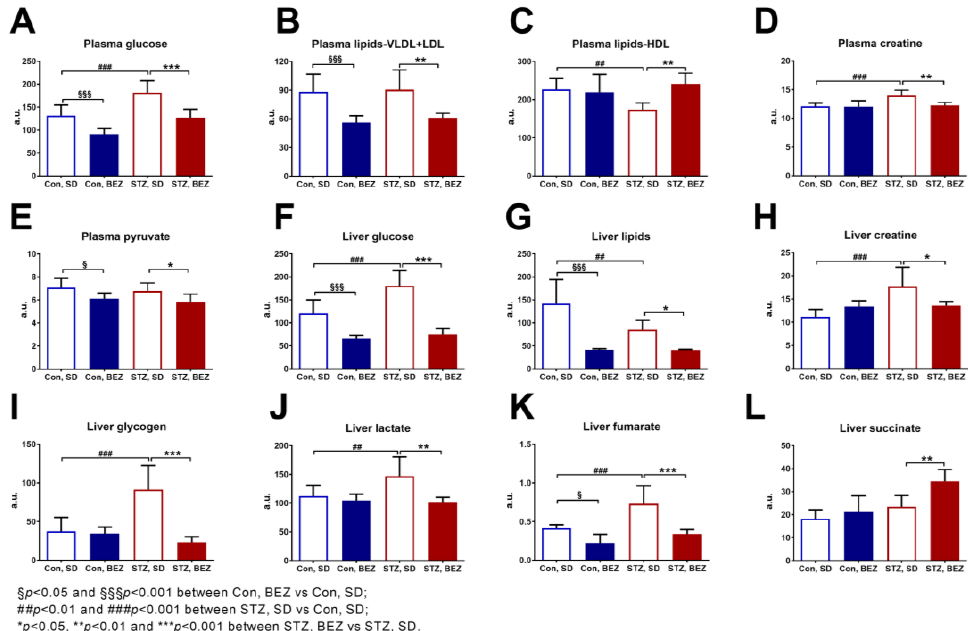
Figure 4. NMR-based metabolomics analyses in plasma and liver samples of BEZ-treated STZ mice. Metabolites measured in ( A – E ) plasma and ( F – L ) liver samples. Columns represent averages ± standard deviation; n = 6-8. ANOVA with post hoc Holm – Sidák multiple comparison test was applied. Abbreviations: VLDL: very-low-density lipoprotein, LDL: low-density lipoprotein, HDL: high-density lipoprotein, a.u.: arbitrary unit.